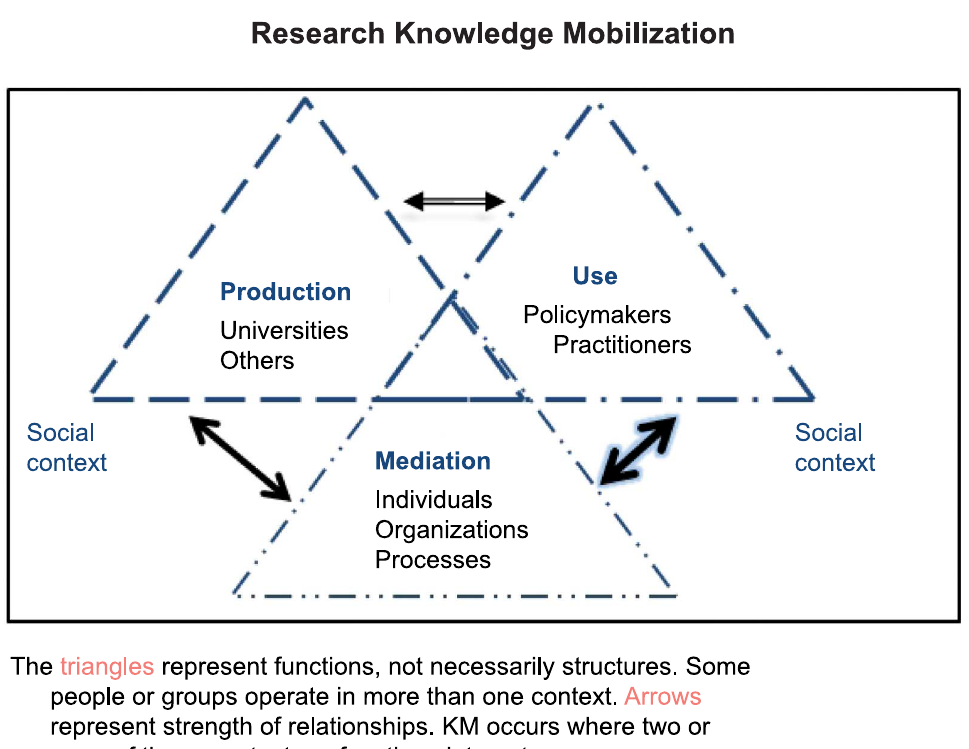
Figure 1. Research knowledge